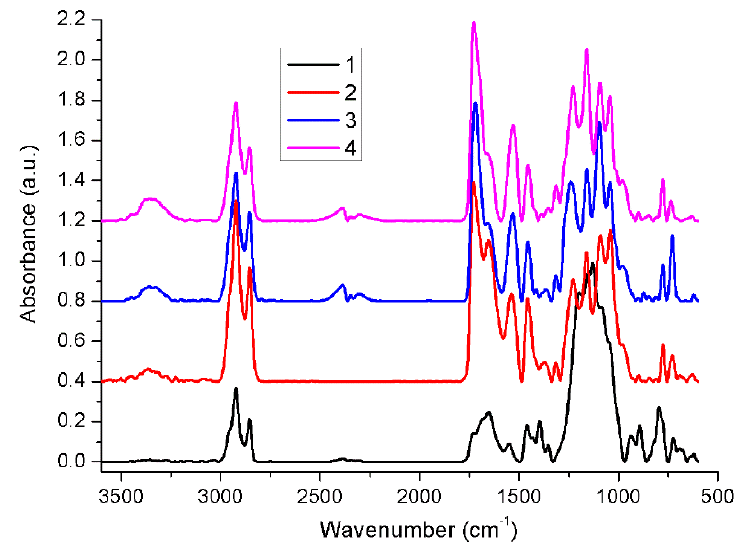
Figure 1. FTIR spectra of the studied samples 1–4.